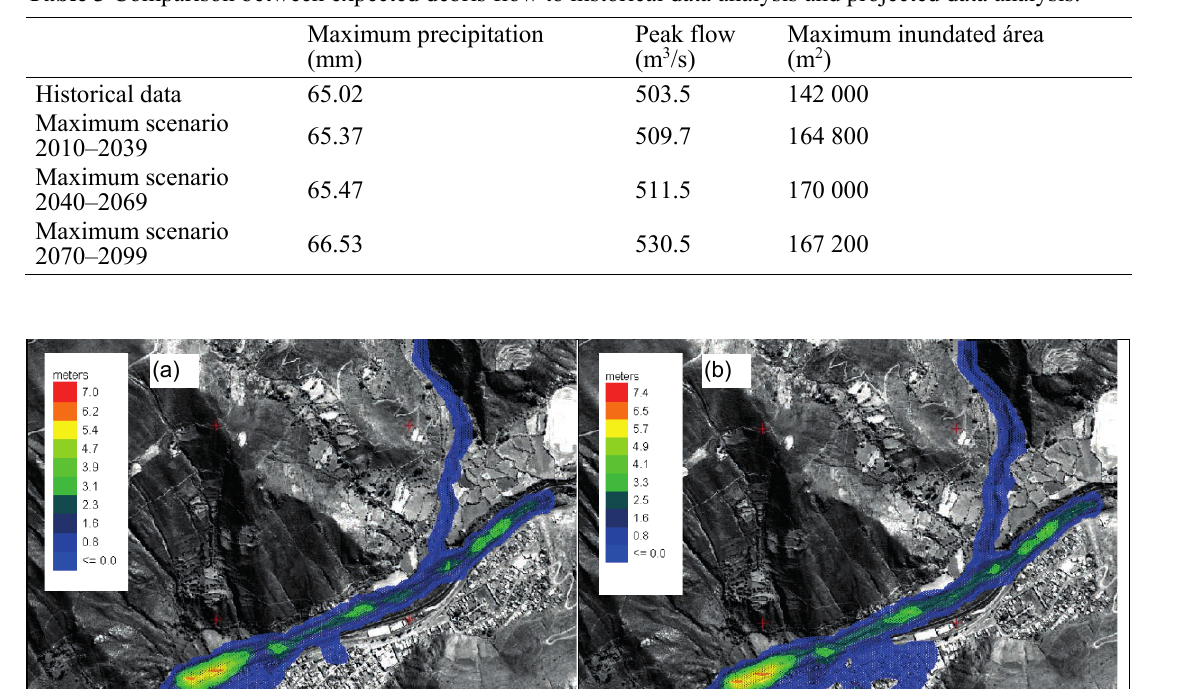
Table 3 Comparison between expected debris flow to historical data analysis and projected data analysis.